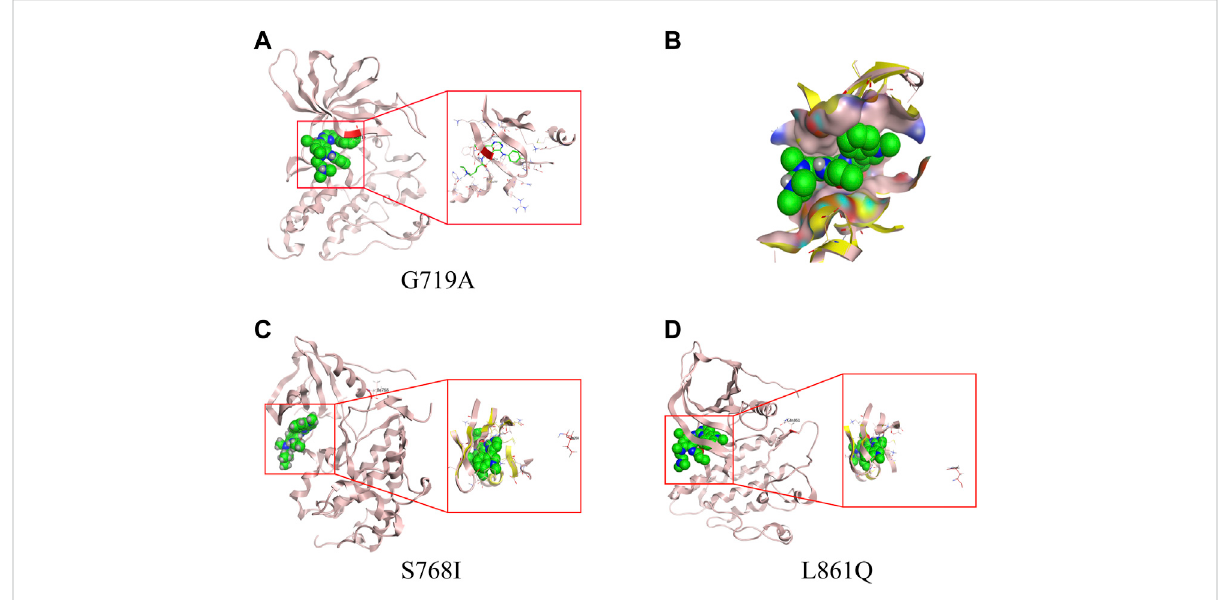
FIGURE 3 3D-based homology models with different uncommon EGFR subtypes. (A) G719A conformation. (B) drug-binding pocket of G719A (pink) and EGFR wild type (yellow). Protein structure and drug-binding pocket of conformation S768I (C) and L861Q (D)